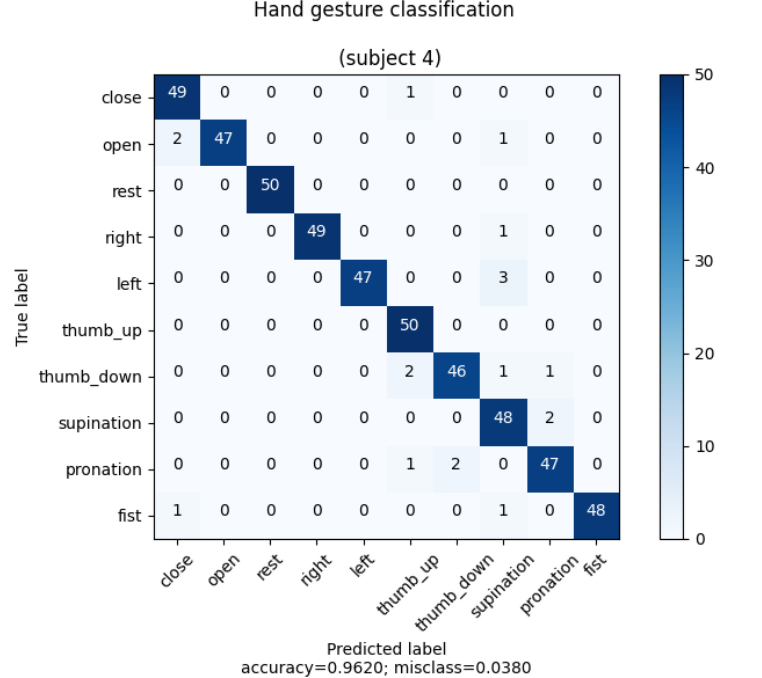
Figure A4. Confusion matrix of a subject who participated in data collection (subject